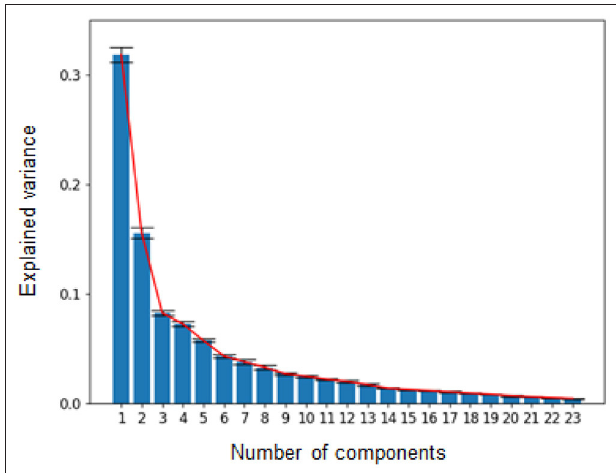
FIGURE 8 | Scree plot of the latent factor